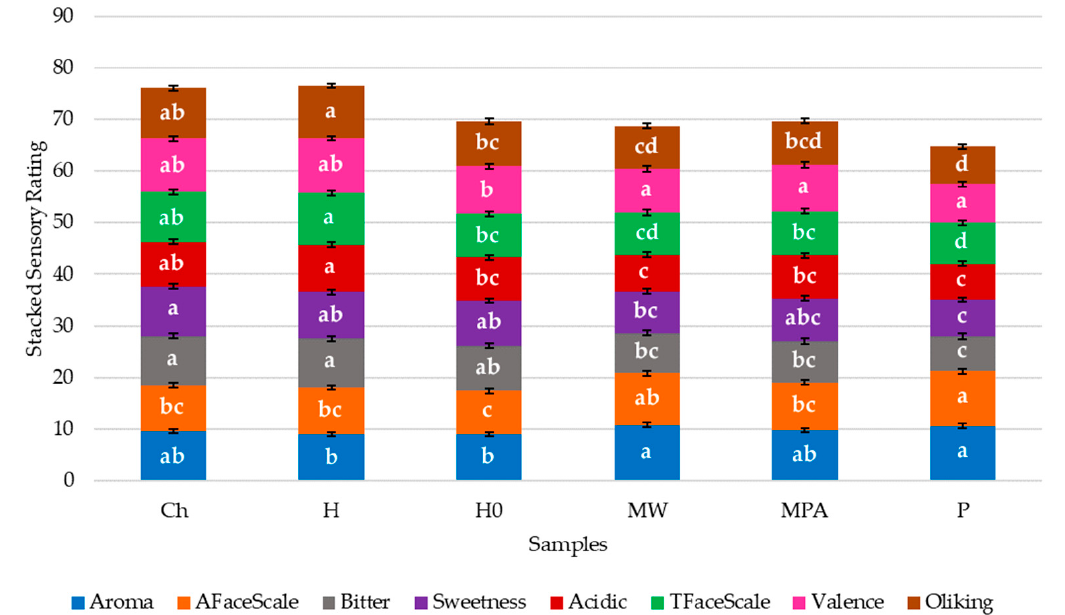
Figure 2. Stacked graph showing the means and standard error bars of the statistically significant self-reported consumer sensory responses. Different letters a–d denote significant differences according to the ANOVA and Fisher’s least significant difference (LSD) post hoc test ( α = 0.05). Abbreviations: AFaceScale: FaceScale from aroma; TFaceScale: FaceScale from taste; Oliking: overall liking. Sample abbreviations are shown in Table 1.